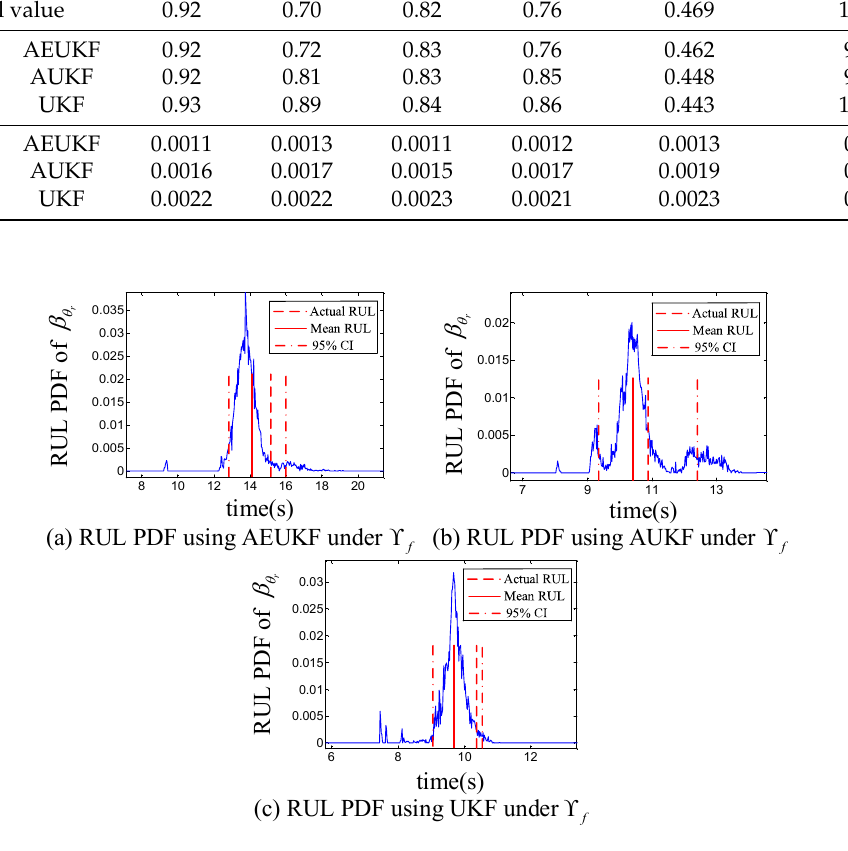
Figure 15. Estimation results: ( a ) Estimate of β θ r ; ( b ) Response of Ψ . Table 6. Comparison of fault estimation performance. with M = 80. Figure 16a–c, respectively, give the The RUL prediction is carried out for r . The predicted mean RUL is f 14.07 s for AEUKF, 13.84 s for AUKF, and 13.42 s for UKF. For all methods, the actual RUL remains